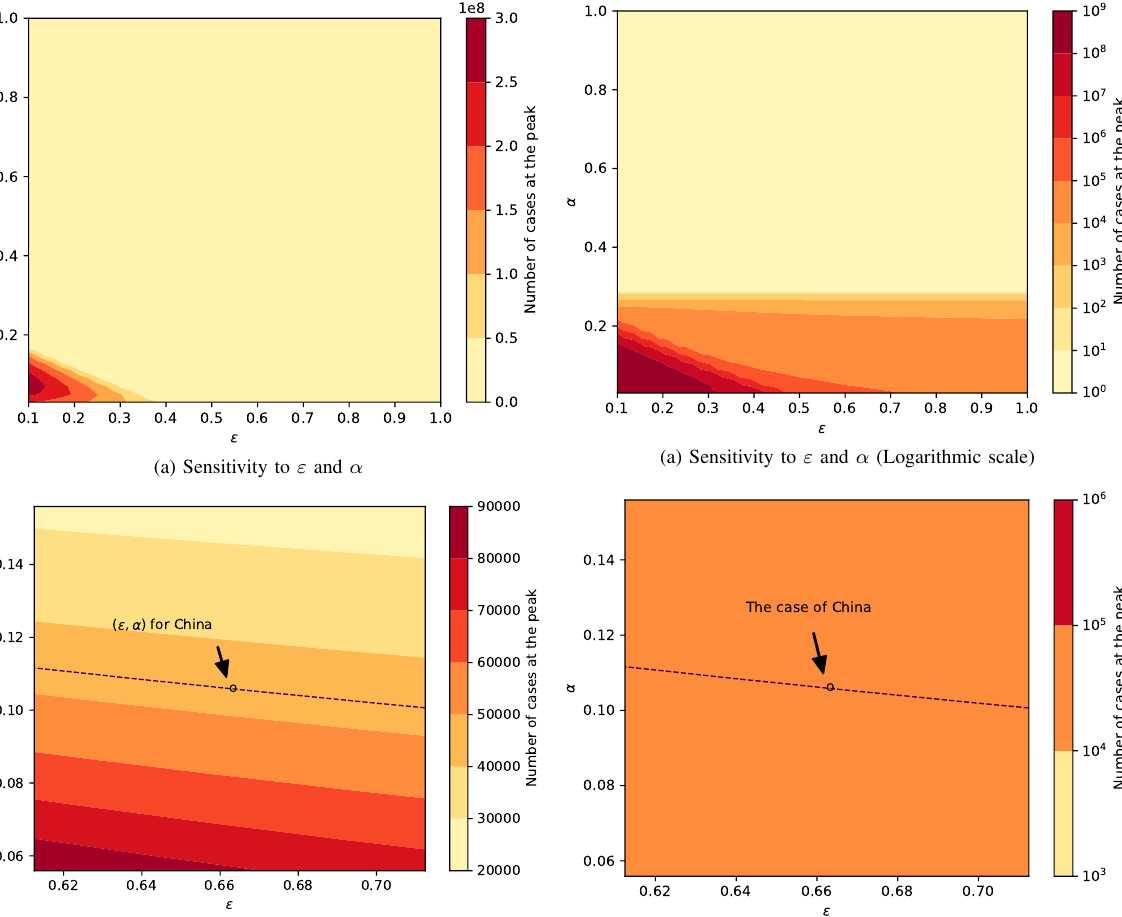
Fig. 7: Sensitivity of the number of active infected cases at the peak to the detection rate α and efficacy ε of protective measures (Logarithmic